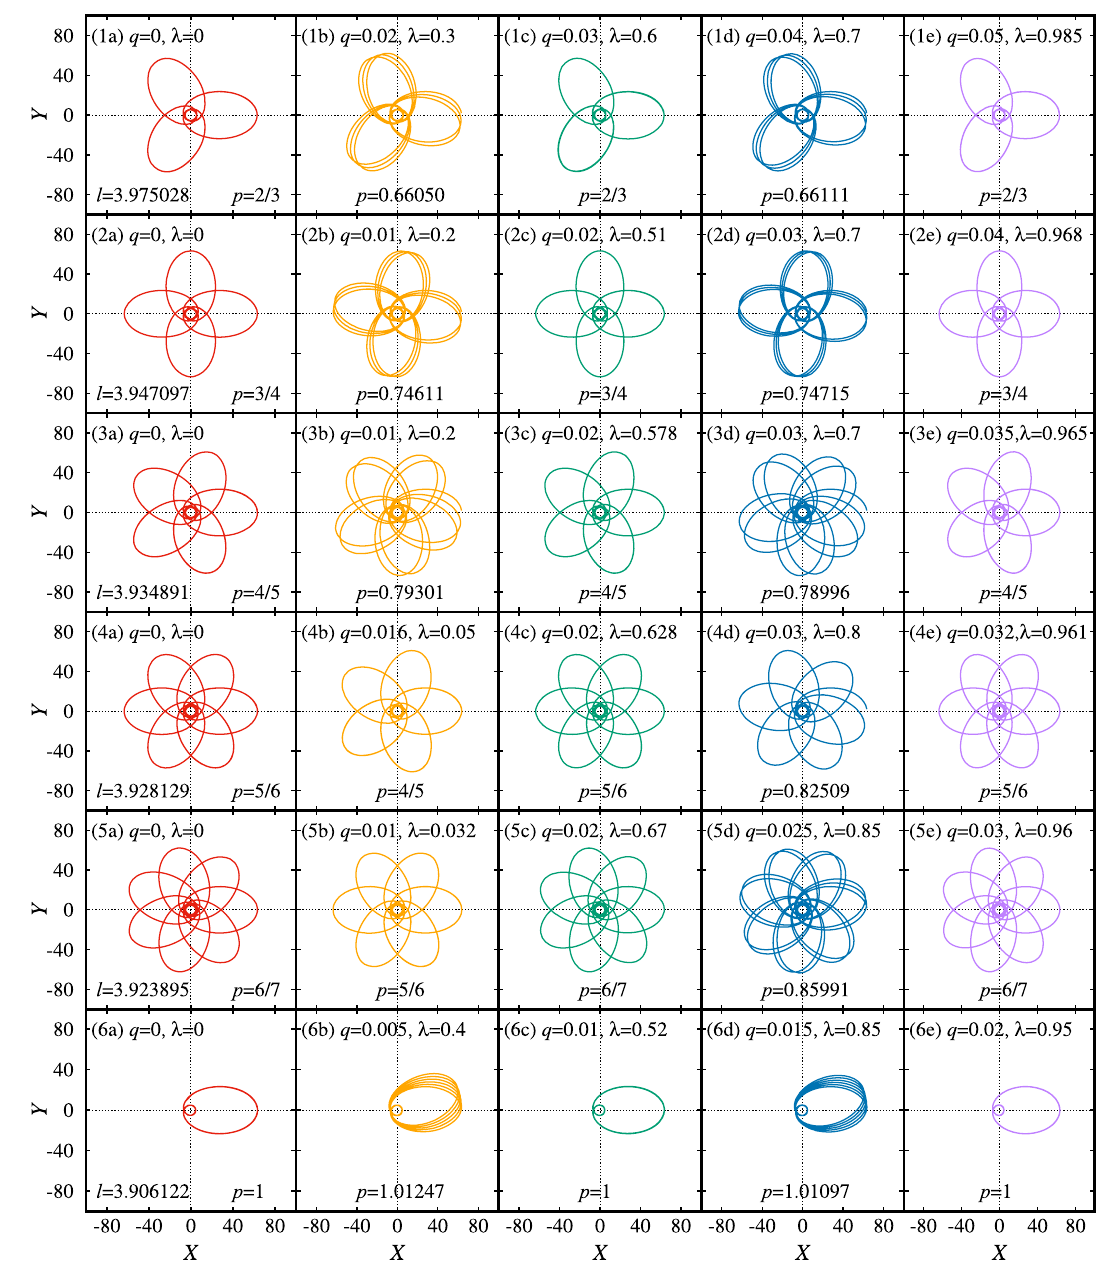
Fig. 6 Some examples of bound orbits around the black-bounce- Reissner–Nordström spacetime with E = 0 . 986, where ( X , Y ) is defined by Eq. (48) and the unique p is denoted in each panel. Each